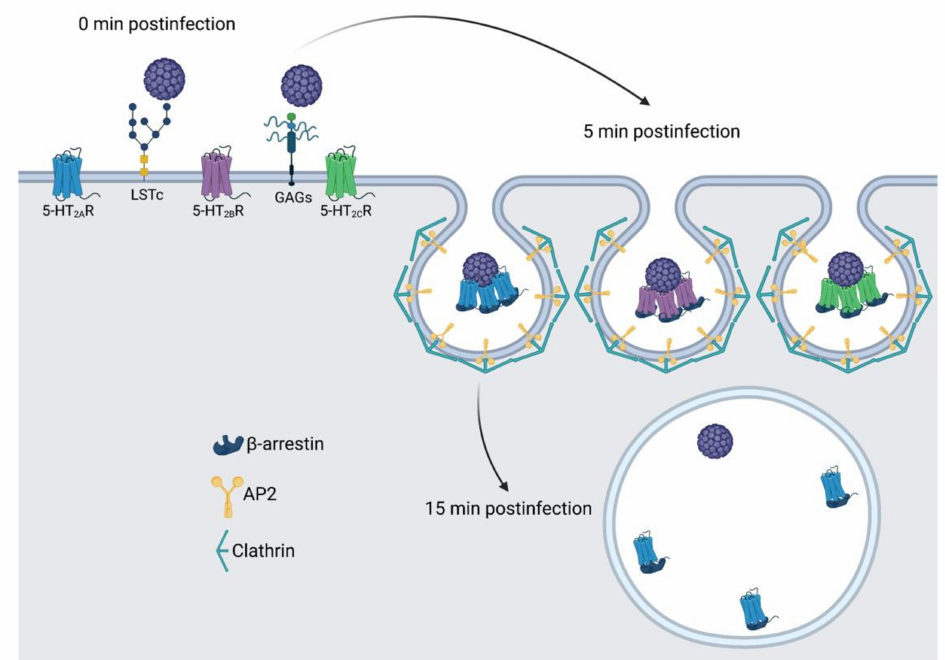
Figure 8. Model of 5-HT 2 R reorganization and clustering during JCPyV entry. Receptor-mediated infection of JCPyV is initiated by attaching to cell-surface receptors including sialic-acid containing LSTc or GAGs, shown at 0 mpi. At 5 mpi, 5-HT 2 Rs cluster and virions are localized to the center of the cluster, and this timing is consistent with viral entry via clathrin-mediated endocytosis. At 15 mpi, receptor clustering of 5-HT 2 Rs is not observed, and the virus may be deposited in an early endosome. Figure not to scale. Figure created using